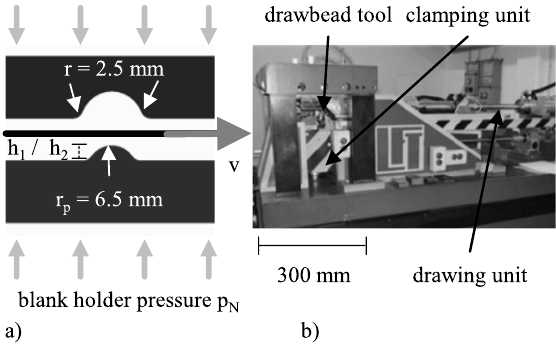
Fig. 2. Methodology used for tensile test examination of preloaded specimens after